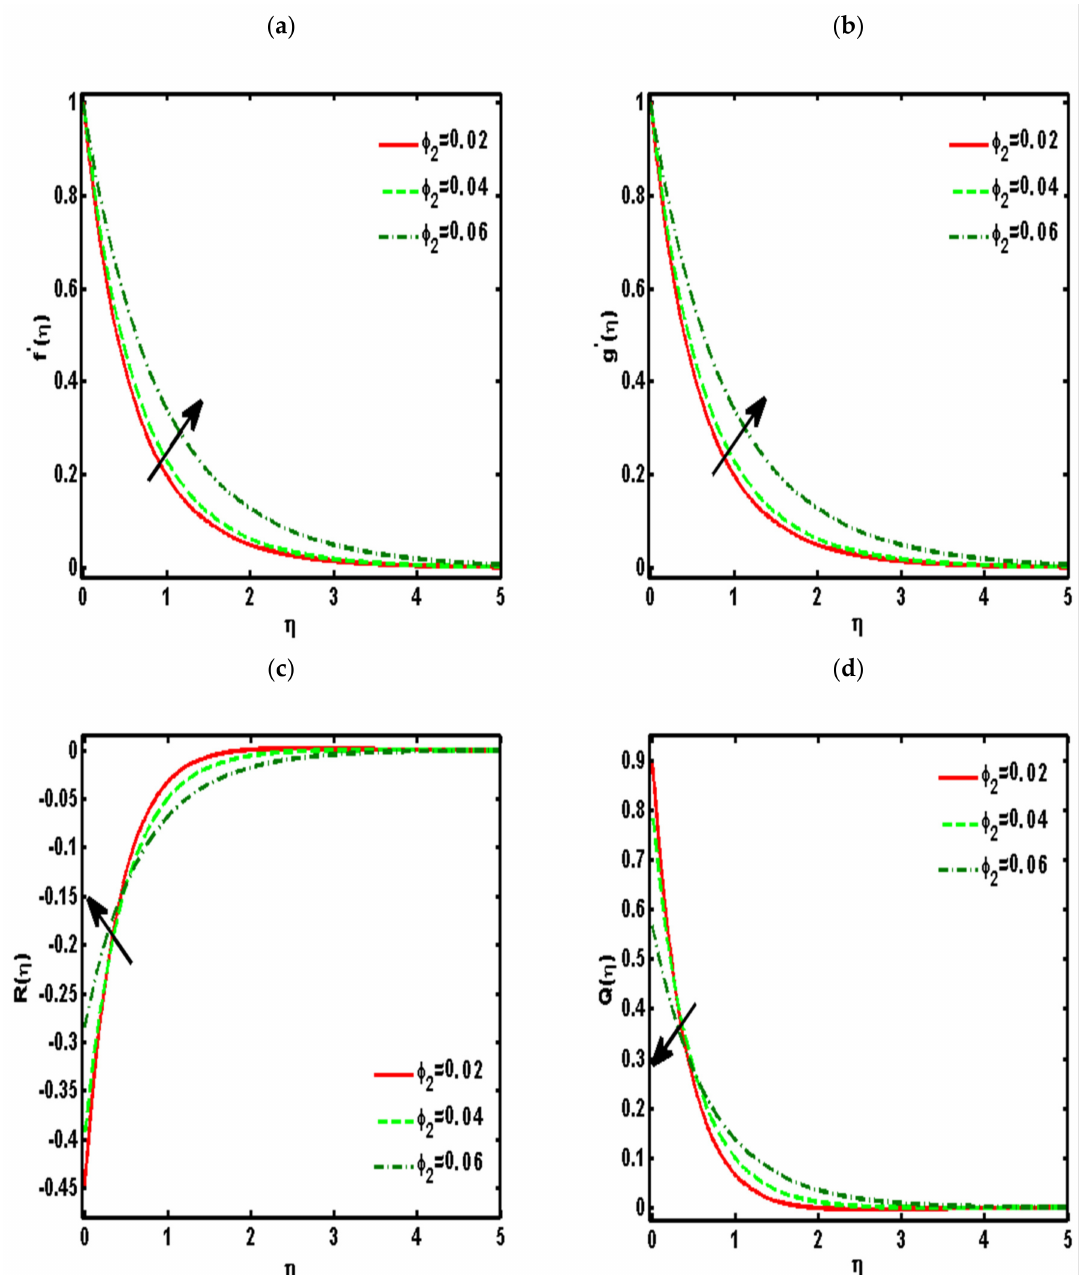
Figure 2. Effects of the nanoparticle volume fraction ( φ 2 ) on ( a ) f (cid:48) ( η ) , ( b ) g (cid:48) ( η ) , ( c ) R ( η ) , ( d ) Q ( η ) . ( Pr = 6.2, K = 0.5, a = 0.5, c =